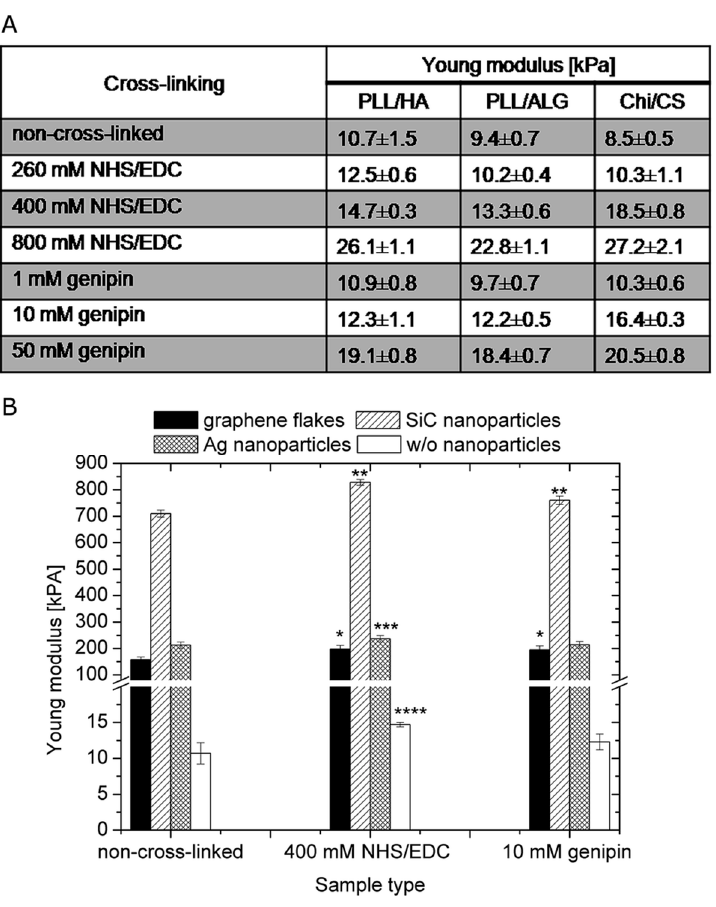
Figure 13. ( A ) The mechanical properties of non-cross-linked, NHS/EDC or genipin cross-linked PLL/HA, PLL/ALG and CHI/CS films. ( B ) The Young’s modulus of PLL/ HA films modified by graphene flakes, silicon carbide or silver nanoparticles , as well as films without nanoparticles is shown. Results obtained for non-cross- linked, 400 mM NHS/EDC and 10 mM genipin cross-linked samples are presented. * represents p < 0.05 vs. non-cross-linked sample with graphene flakes; ** represents p < 0.05 vs. non-cross-linked sample with SiC; *** represents p < 0.05 vs. non-cross-linked sample with Ag; **** represents p < 0.05 vs. non-cross-linked sample without nanoparticles. Figure taken from reference [183], C opyright © 2020 Royal Society of Chemistry.